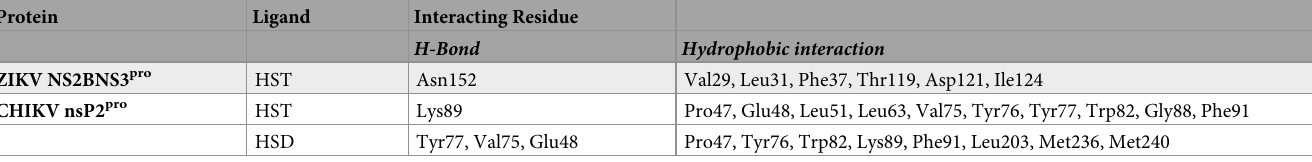
Table 3. Residues involved in forming H-bonds and hydrophobic contacts between the proteins and the ligands.